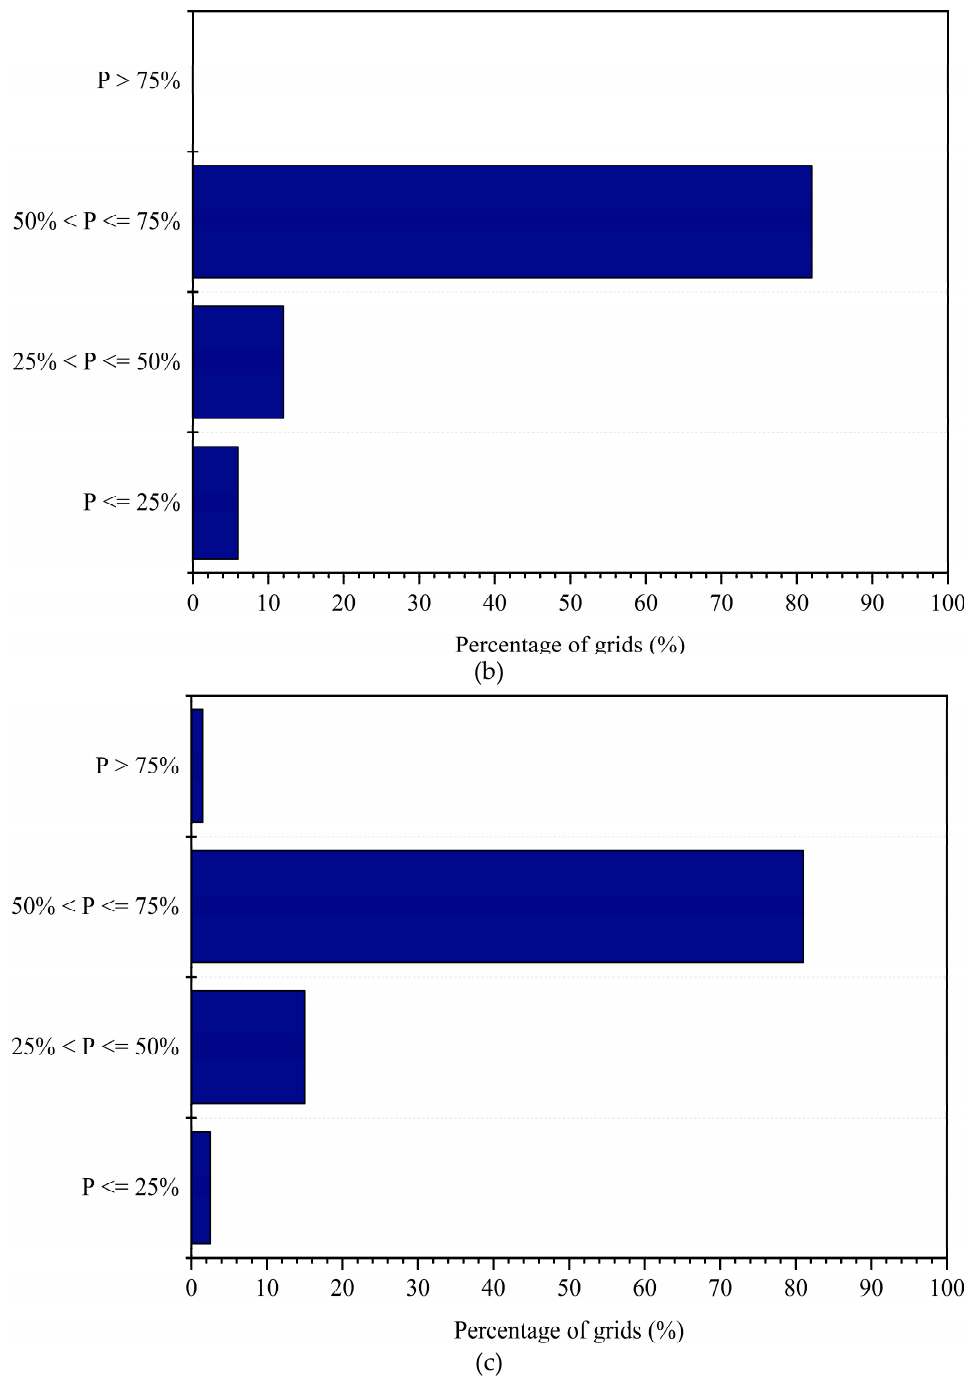
Figure 8. The percentage of grids in the four intervals of PDWs for 2015 ( a ), 2016 ( b ), and 2017 ( c ).